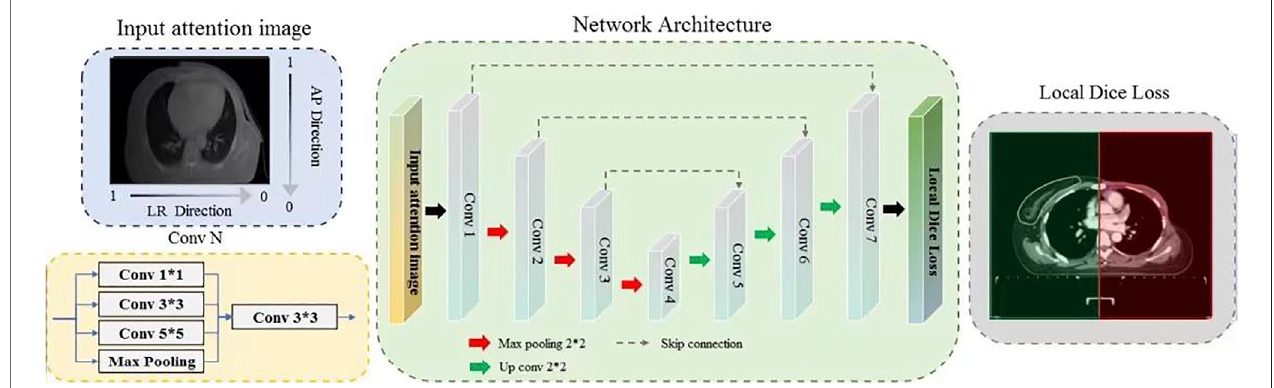
FIGURE 1 | Illustration of the speci fi cally designed deep-learning based multi-objective segmentation method for the automatic delineation of CTVs for Radiotherapy after Modi fi ed Radical Mastectomy. Input attention images are obtained by overlapping an anterior-posterior (AP) direction attention map on to input